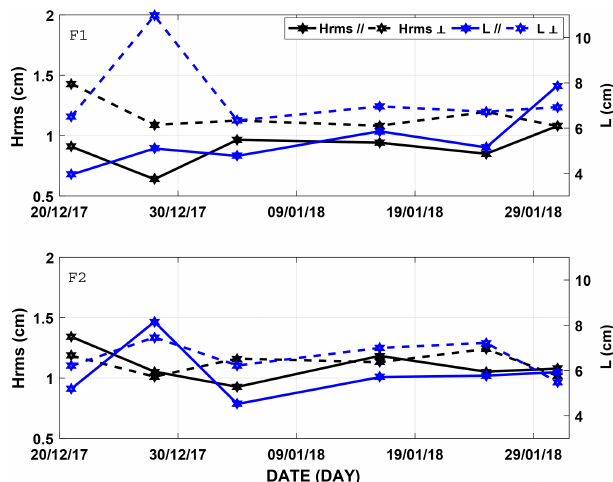
Figure 4. Time series of h rms and L computed from parallel and perpendicular measurements separately for F1 and F2 during the season 2017/18.